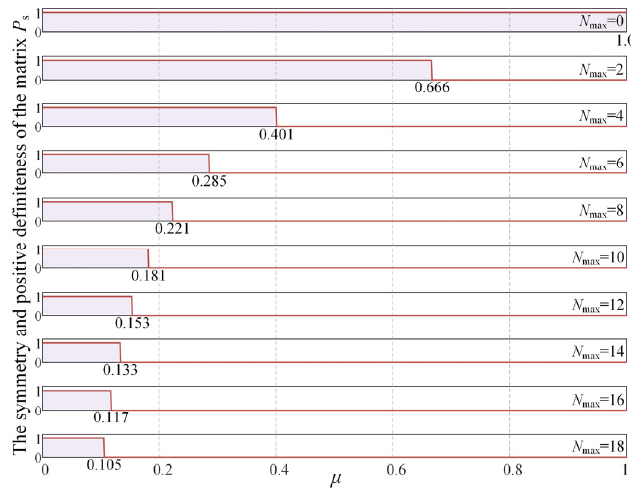
Figure 6. The relationships between symmetric positive definiteness of the stability-related matrix P s and parameter µ under various N max .